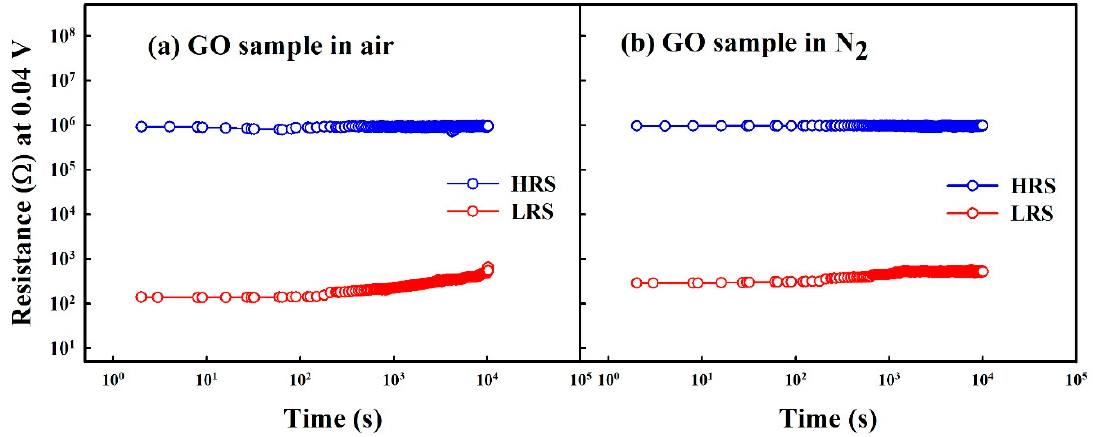
Figure 6. Retention characteristics of the GO sample in ( a ) the atmosphere and ( b ) the N 2 ambient.